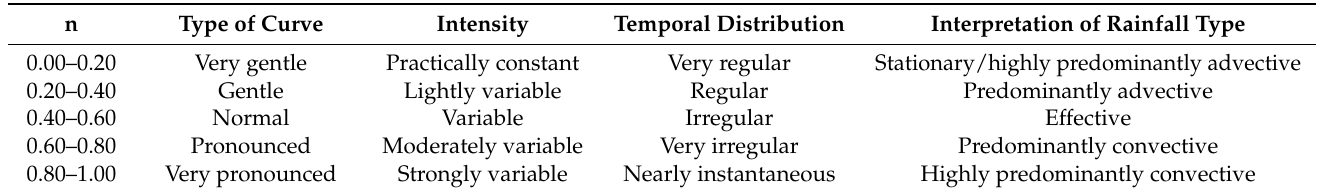
Figure 3. Observed values [I 10-min ; I 60-min ]. Table 2. Storm classification according to intensity regularity vs. time. Adapted from Refs. [37,38].